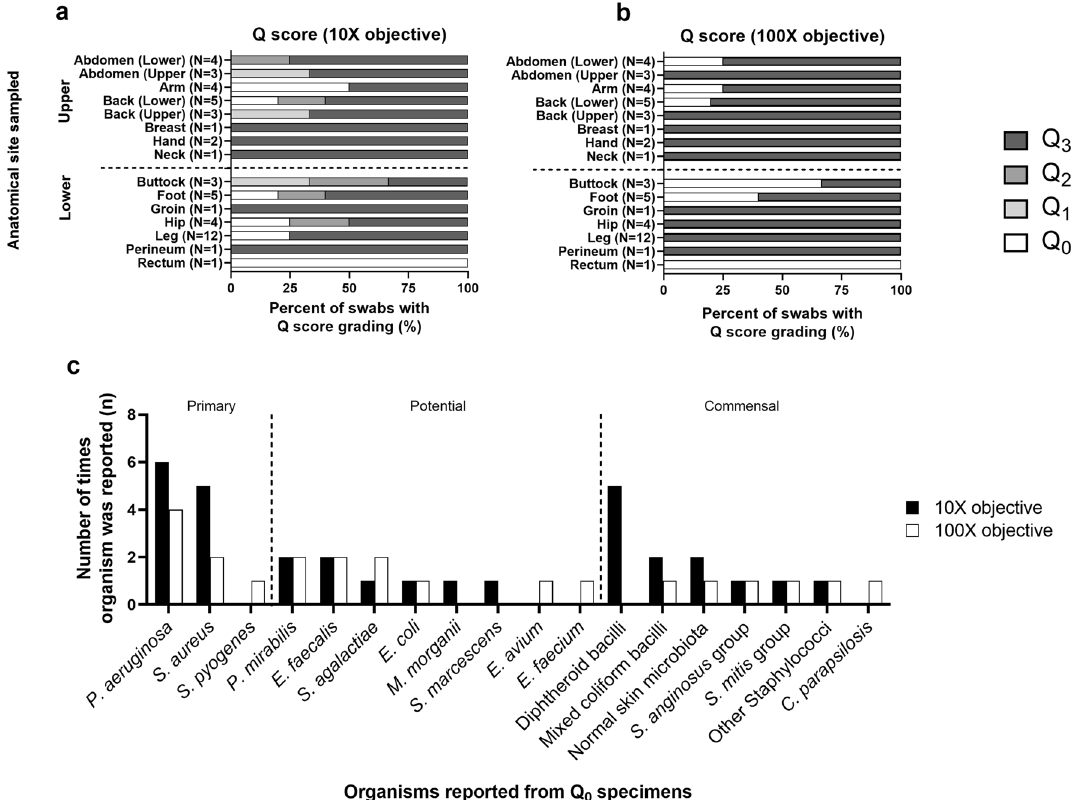
Figure 1. Comparison of Gram smear grading approaches to evaluate wound swab quality. Swabs (N = 50) from 40 patients were examined using Q score grading under ( a ) low power (10X) and ( b ) high power (100X) objectives to mimic the criteria currently used by the laboratory (100X semi quantitative reporting of PMN, SEC and organisms) and ( c ) differences in pathogens identified among Q 0 swabs. Organisms were classified as primary or potential pathogens or commensal organisms was based on current laboratory